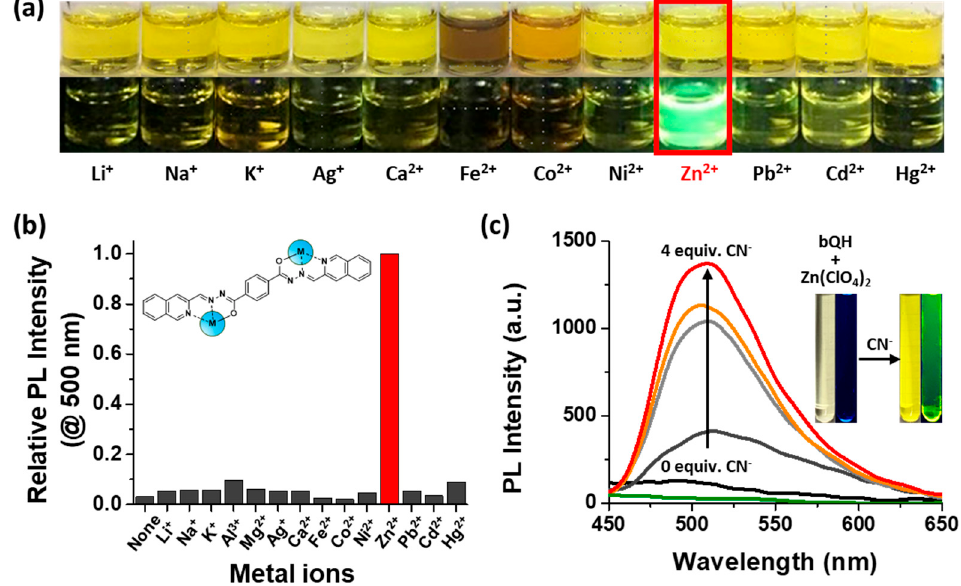
Figure 2. Selective binding of bQH to Zn 2 + ion. ( a ) Images of bQH solutions (5.0 × 10 − 3 M in DMSO) mixed with an excess amount of each metal ion (upper). The same samples were placed under a 365 nm UV lamp (bottom). ( b ) Comparison of the photoluminescence (PL) intensity of bQH (5.0 × 10 − 6 M in DMSO) with 2.0 equivalents of metal ions at λ = 500 nm, presented relative to the PL intensity of bQH with Zn 2 + ion. ( c ) Increment in PL intensity of bQH (5.0 × 10 − 6 M) with 4.0 equivalents of Zn(ClO 4 ) 2 by addition of tetrabutylammonium cyanide (TBA-CN) up to 4.0 equivalents in DMSO (measurement conditions: Lamp voltage of 500 V, 5 nm slit width, and λ ex = 350 nm). The green line is the emission spectrum of Zn(ClO 4 ) 2 (2.0 × 10 − 5 M in DMSO). Inset: Color change (left) and PL increment (right) of bQH solution mixed with Zn(ClO 4 ) 2 achieved by adding CN −